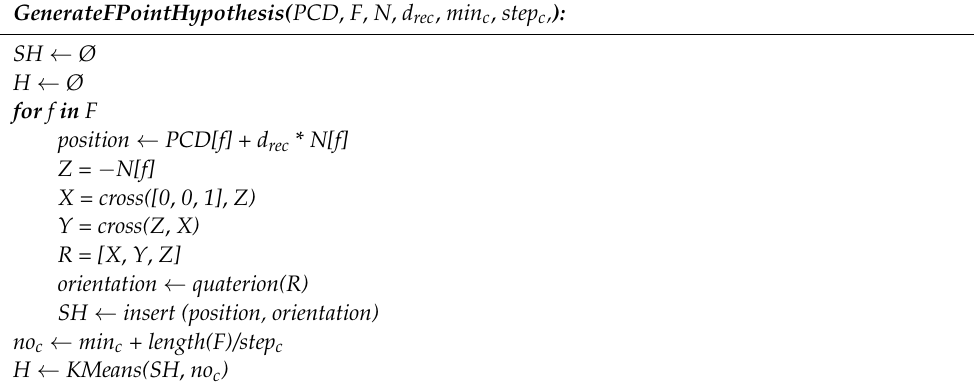
Algorithm 3. Algorithm for Creating Recording Hypothesis from Frontier Point Data